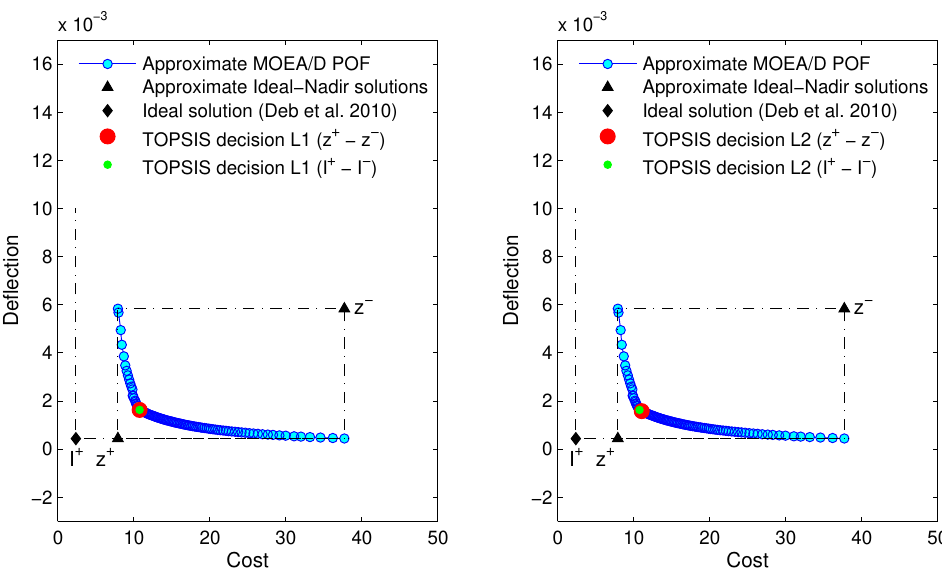
Figure 16. TOPSIS decision with L 1 ( left ) and L 2 ( right ) metrics on the approximate POF with the hypervolume indicator closest to the average value of hypervolume after 100 runs for MOEA/D ( N = 100).